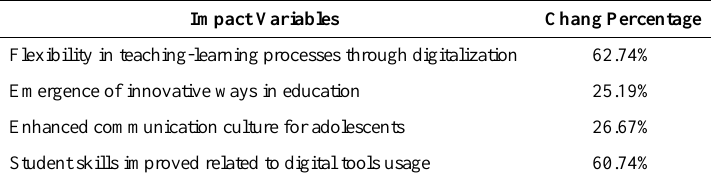
Table 1. COVID-19 has improved the level of digitalization in education